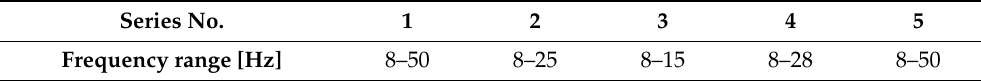
Table 3. Characteristics of excitation series executed during the in situ test. Series